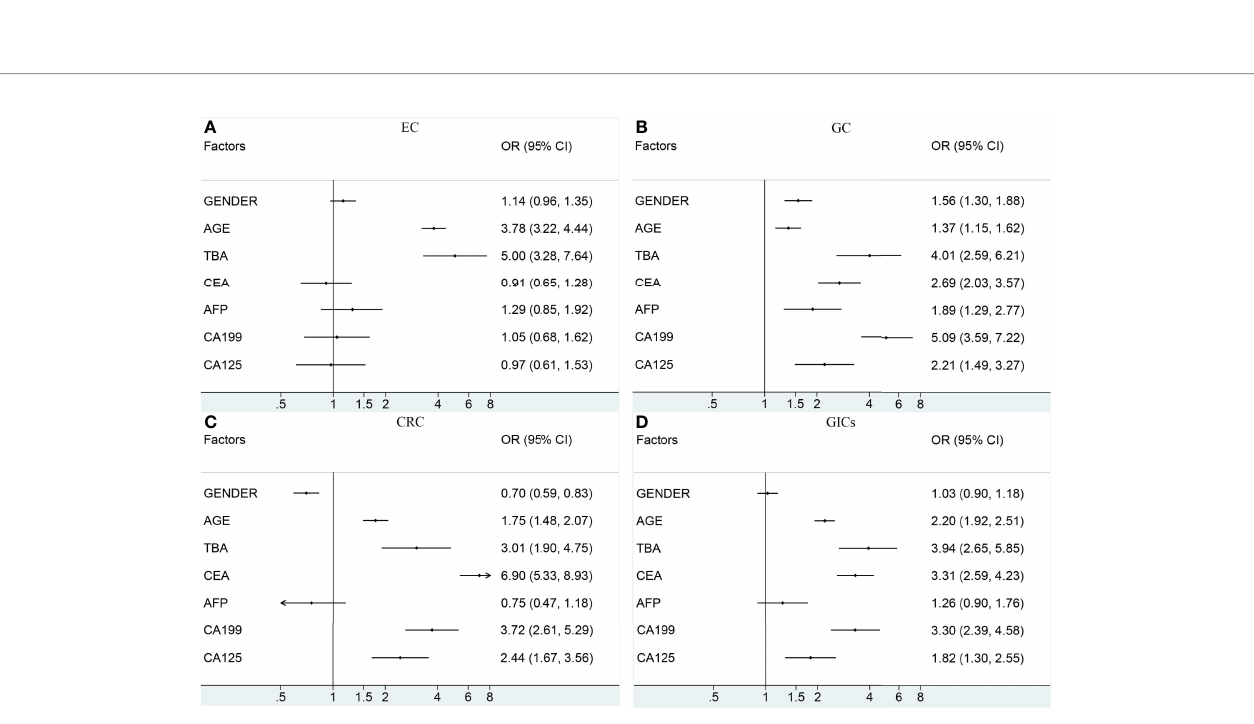
FIGURE 2 | The nonlinear association between different serum TBA levels adjusted for age and the risk of EC (A) , GC (B) , CRC (C) , GIC (D) . The trend fi tted by the blue dots presents the OR values estimated by the restricted cubic spline regression model. The dot indicates that there is at least one actual value of the X axis. TBA, total bile acid; EC, esophageal cancer; GC, gastric cancer; CRC, colorectal cancer; GIC, gastrointestinal cancer; OR, odds ratio; CI, con fi dence